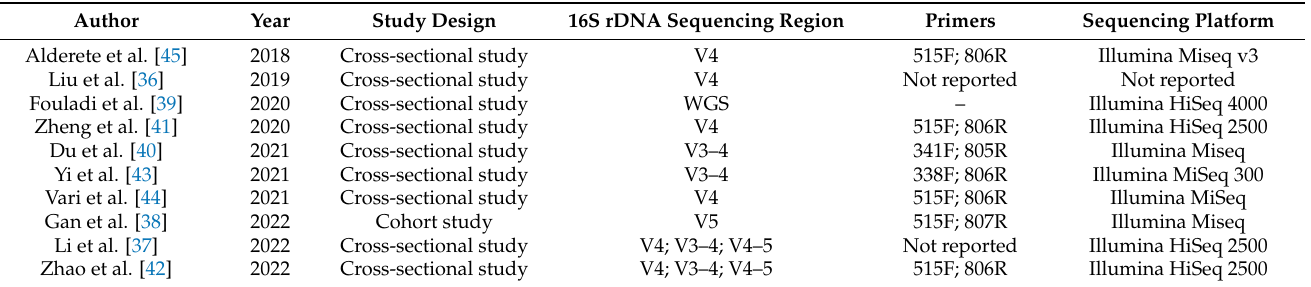
Table 2. Study design, 16S rDNA sequencing regions, primers, and sequencing platform adopted by the included